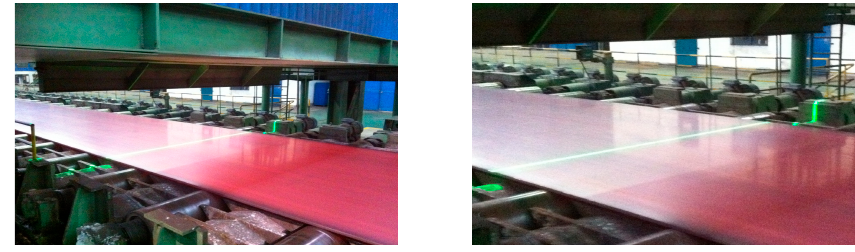
Figure 2. Surface inspection system of hot rolled steel plates with green linear laser lighting.